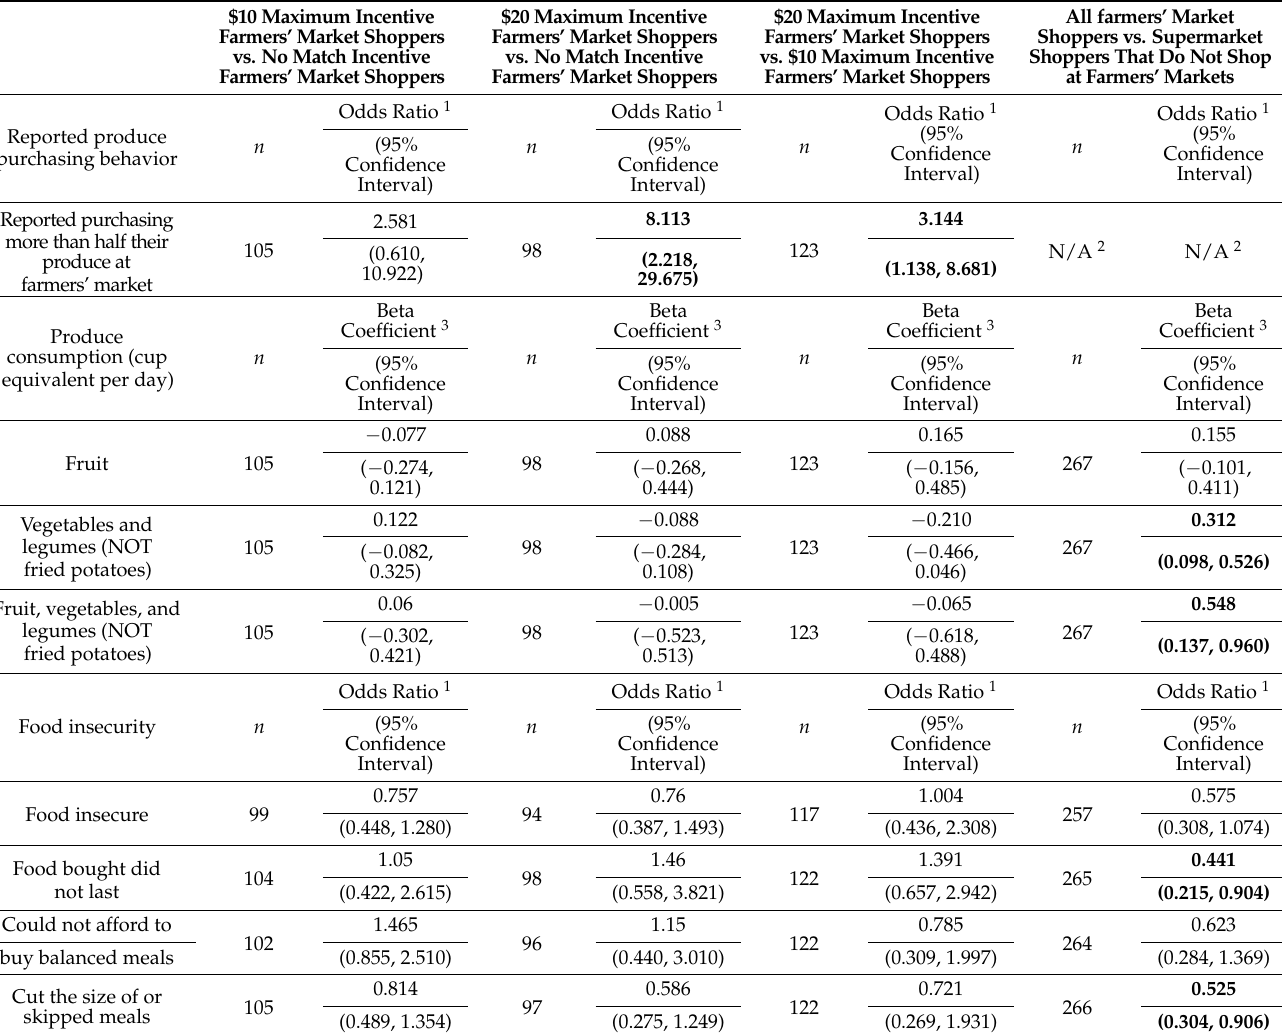
Table 2. Comparisons of reported produce purchasing behavior, produce consumption, and food insecurity by market type: farmers’ market and supermarket shoppers participating in the California Nutrition Incentive Program evaluation